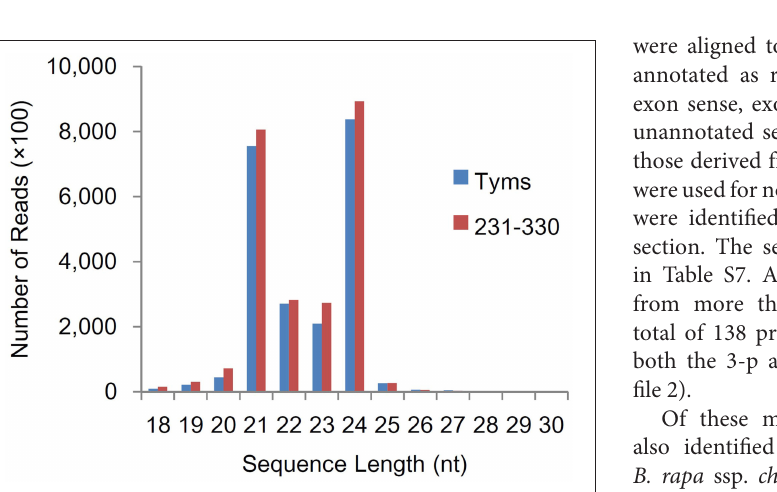
FIGURE 2 | Size distribution of small RNA